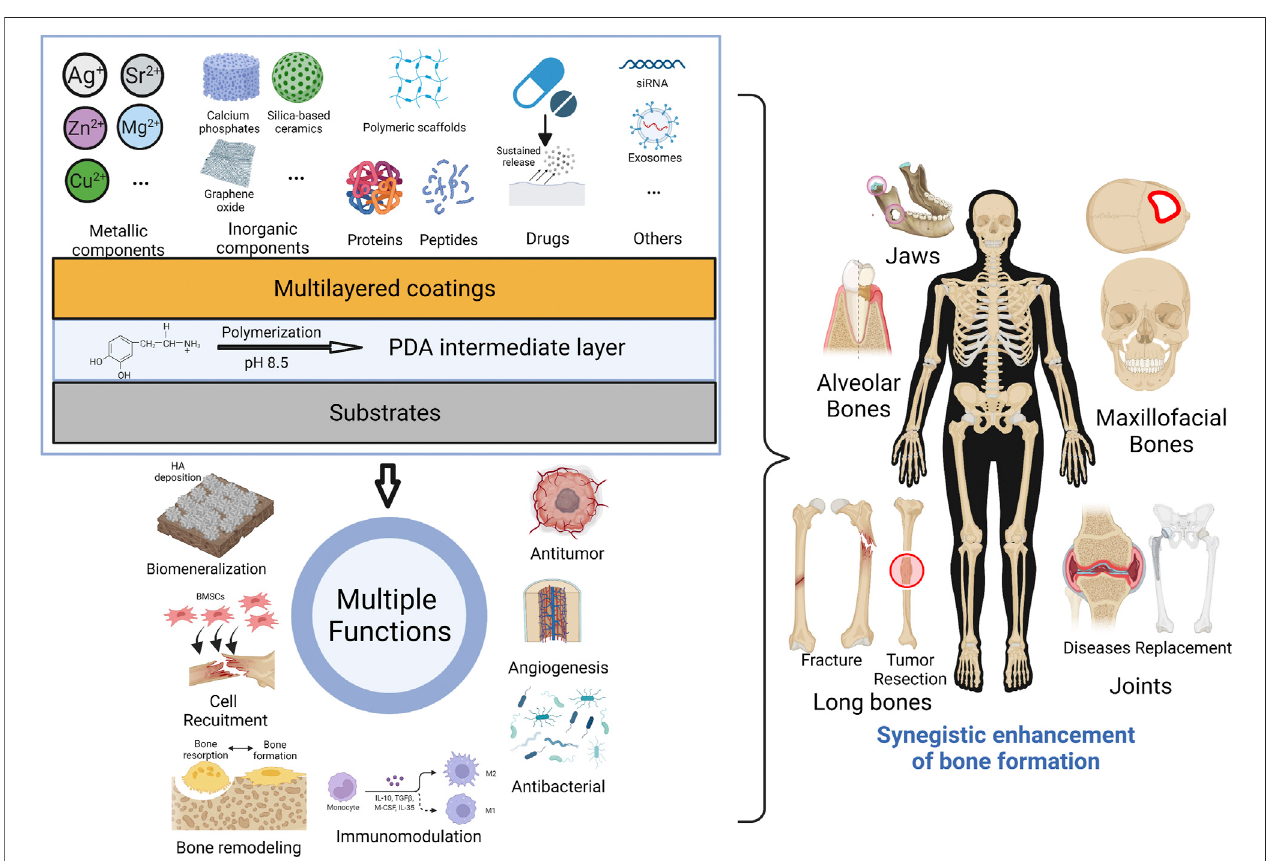
FIGURE 2 | Graphical diagram for fabrication of PDA-based multilayered coatings to achieve multi-functionalization and enhanced bone formation. (Created with BioRender.com).